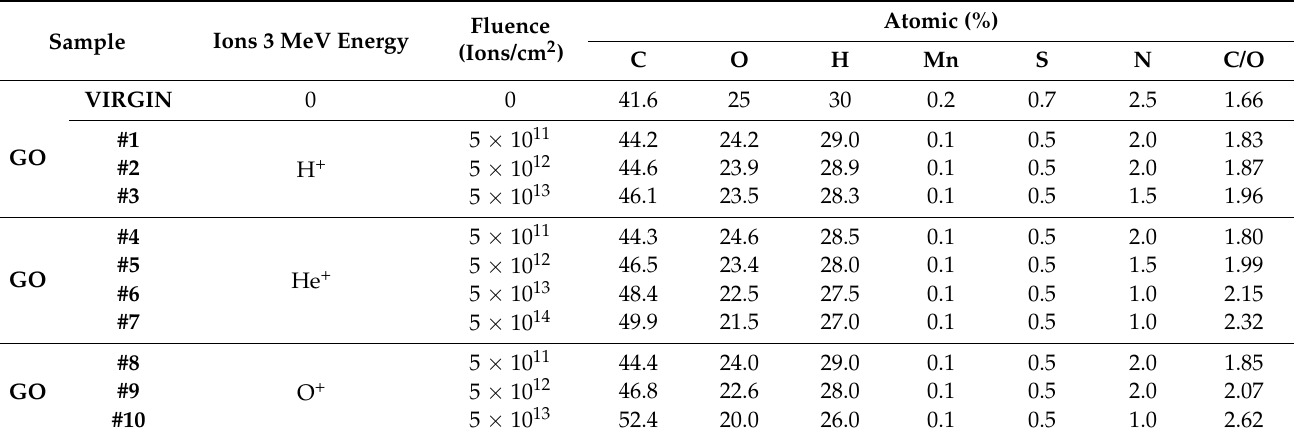
Table 1. Elemental composition of virgin and ion irradiated GO foils at different fluences have been obtained by RBS/ERD analyses.